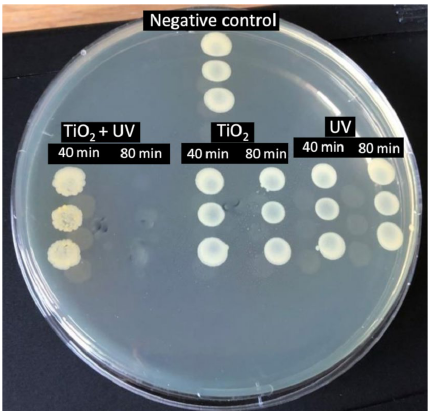
Fig. 10 The ability of mixture of S. enterica and M. luteus cells to form colonies assayed by DP method. Obtained results after overnight incubation at 37